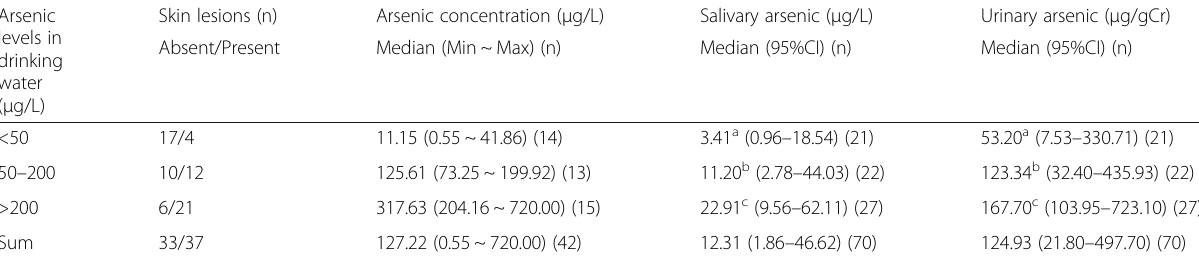
Table 1 Distribution of total arsenic in drinking water, saliva and urine from individuals exposed to different levels of arsenic in drinking water in Shanyin County of Shanxi Province, China